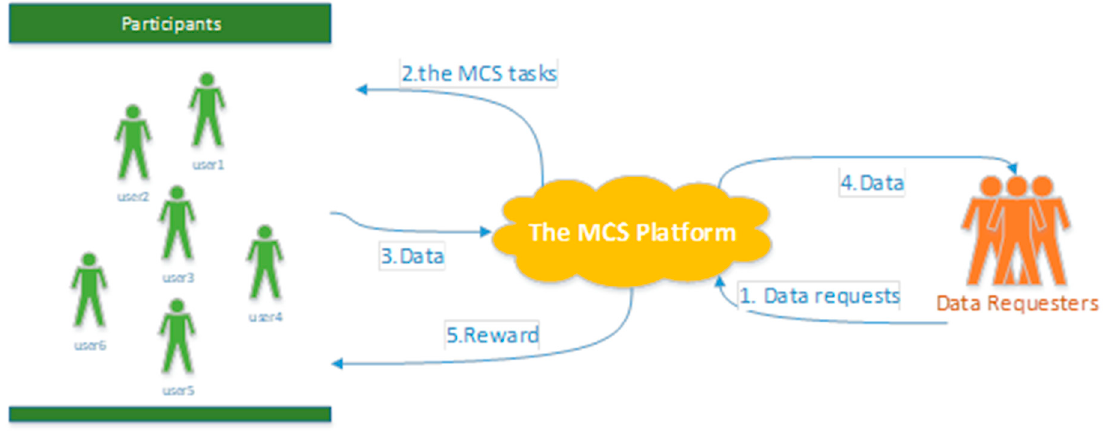
Figure 1. Typical mobile crowd sensing (MCS) system framework.